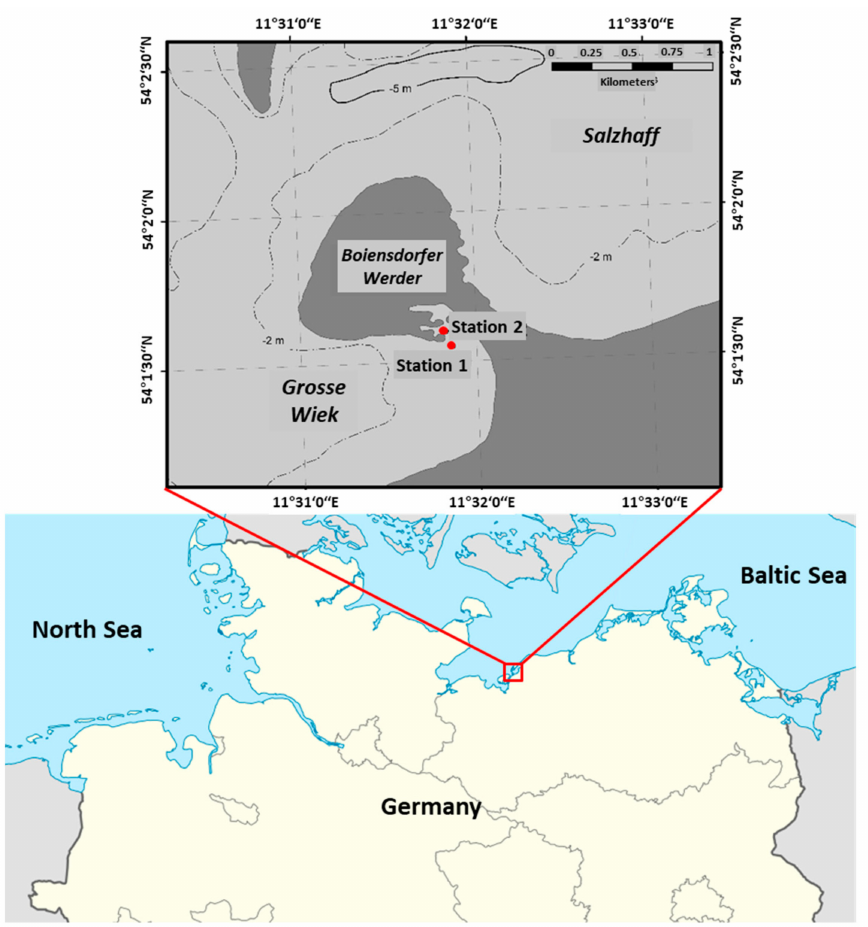
Figure 1. Study site of both sheltered stations S1 and S2 at the Boiensdorfer Werder (southern coast of the German Baltic Sea) where the samples were